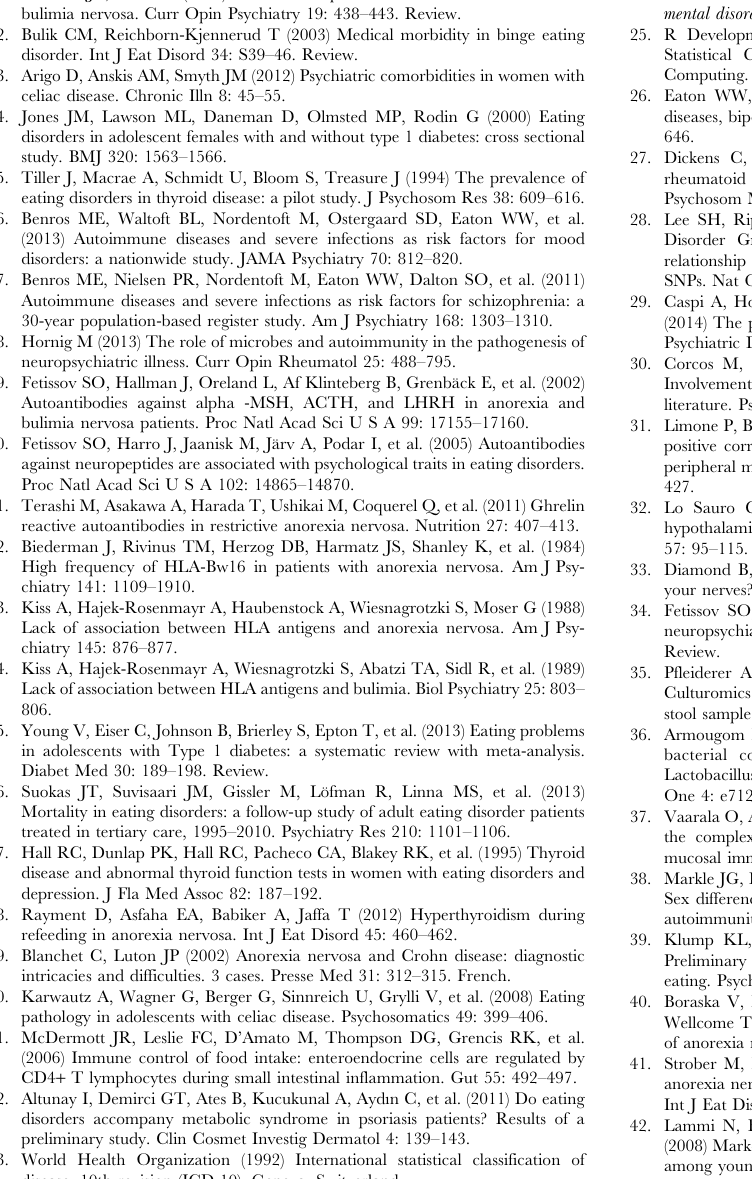
time before, during and after the treatment for an eating disorder for patients with eating disorders and for their control individuals. Odds Ratios (OR) are presented if meaningful analyses were